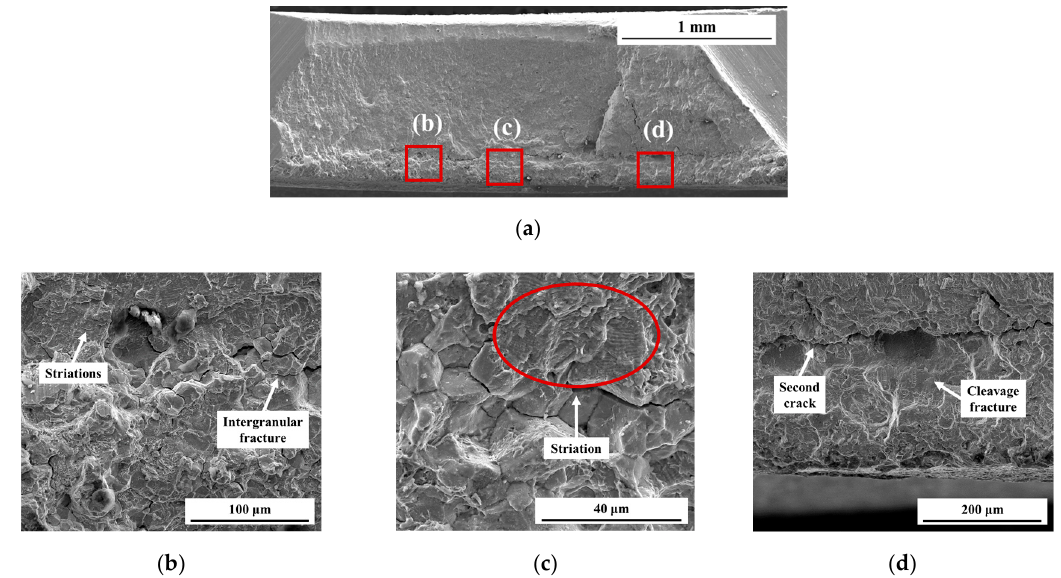
Figure 11. Fatigue fracture surface at pull-out failure mode: ( a ) overall view, ( b ) occurrence area of intergranular fracture, ( c ) occurrence area of striation, and ( d ) occurrence area of cleavage fracture.